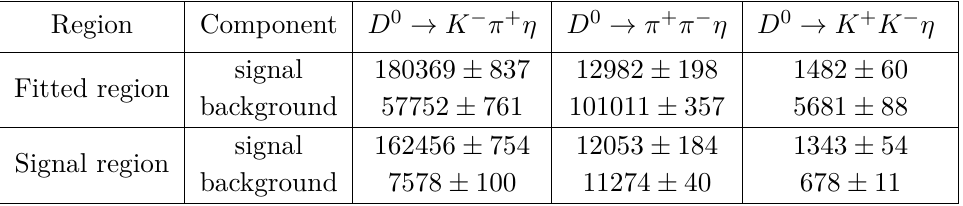
Table 1 . Yields of signal and background events in the fitted region 0 < Q < 15 MeV, and in the signal region | Q − 5 . 86 | < 0 . 80